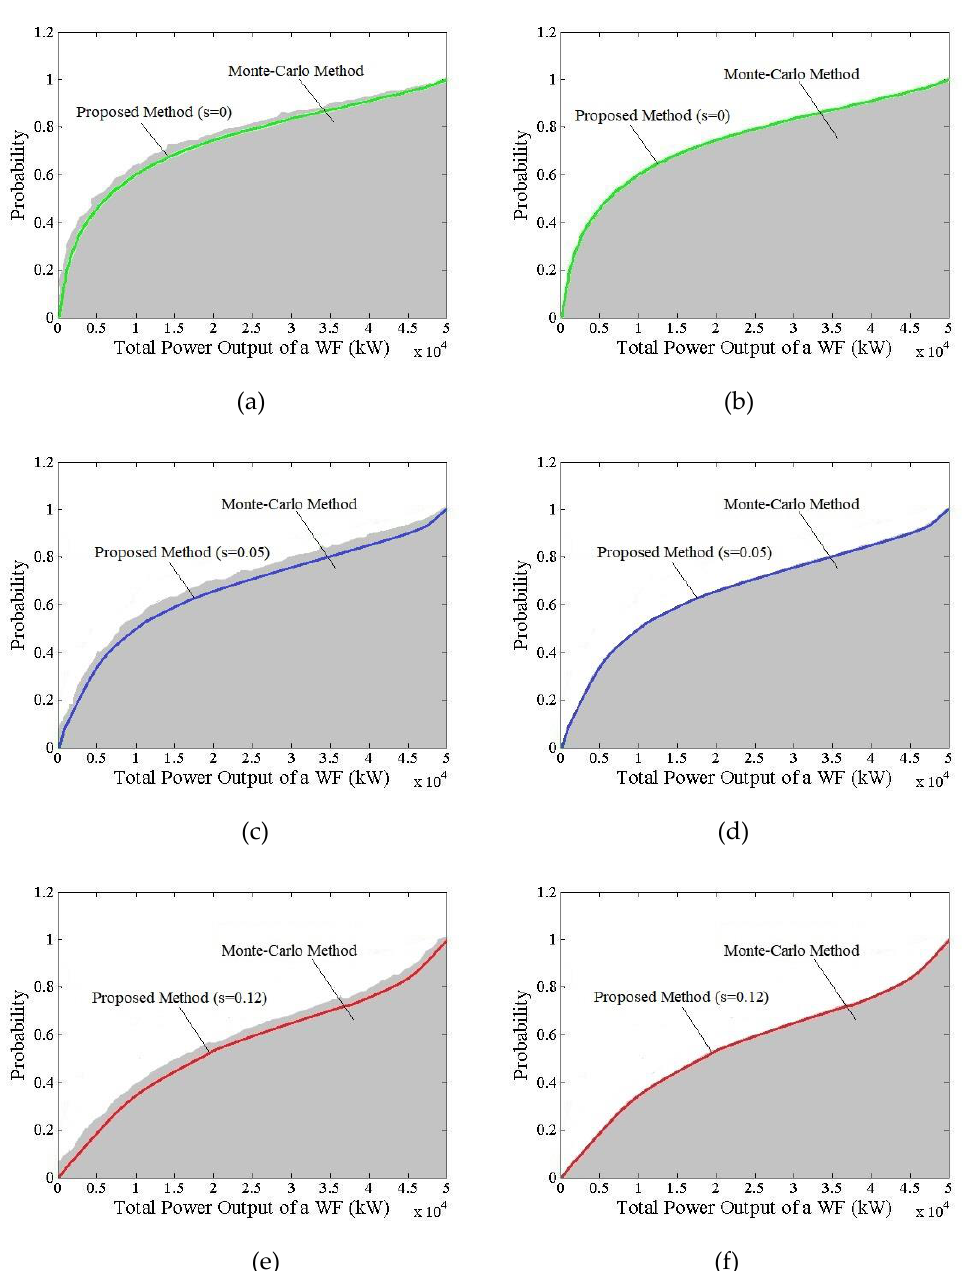
Figure 10. Comparisons of the proposed model and Monte Carlo method with di ff erent slopes. ( a ) sample size = 100, s = 0; ( b ) sample size = 50,000, s = 0; ( c ) sample size = 100, s = 0.05; ( d ) sample size = 50,000, s = 0.05; ( e ) sample size = 100, s = 0.12; ( f ) sample size = 50,000, s =